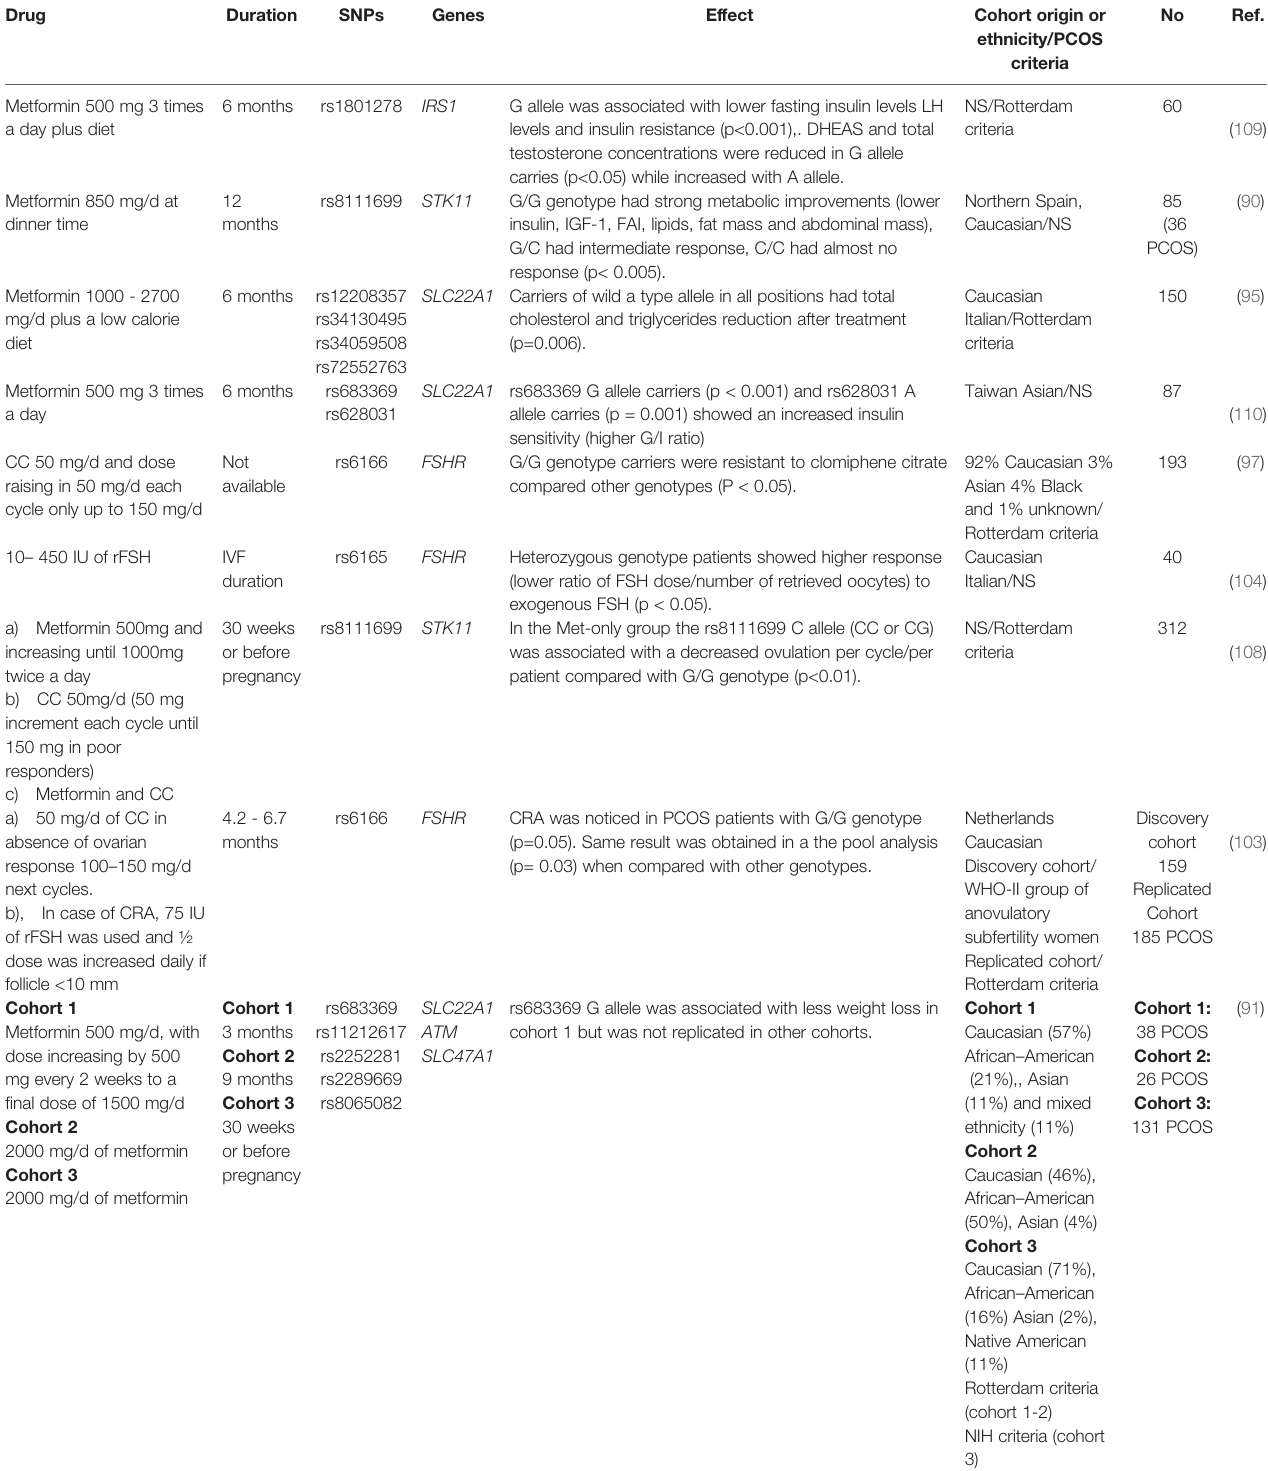
TABLE 5 | Associated SNPs with clinical difference in drugs